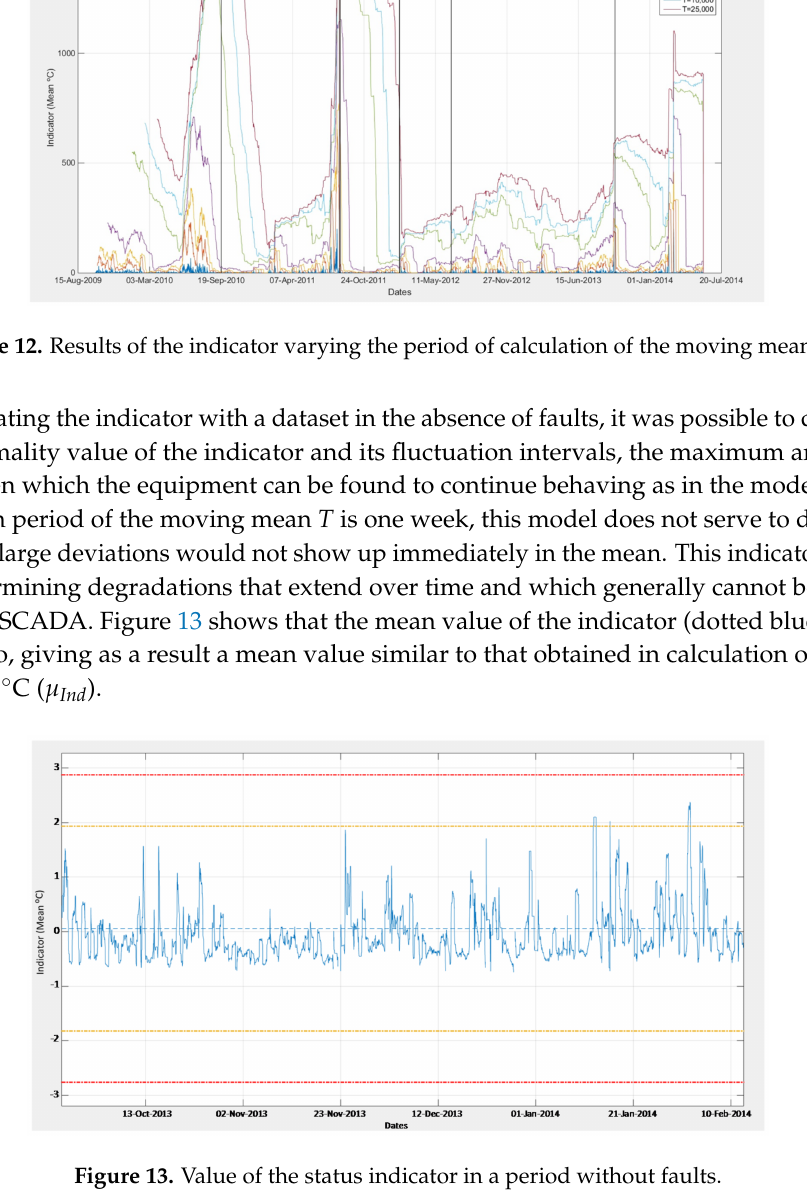
Figure 13. Value of the status indicator in a period without